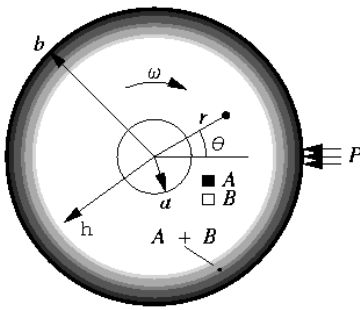
Figure 1. Schematic diagram of functionally graded circular disk model.